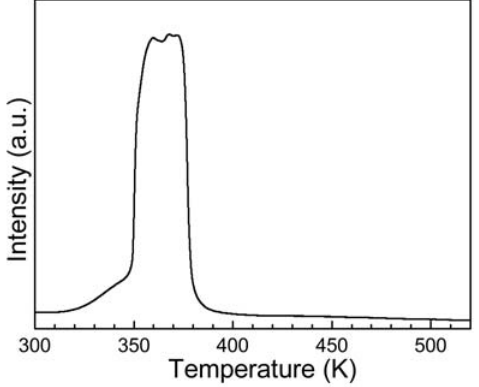
Figure 2. H 2 -temperature-programmed reduction profiles of a non-reduced Ru sample.